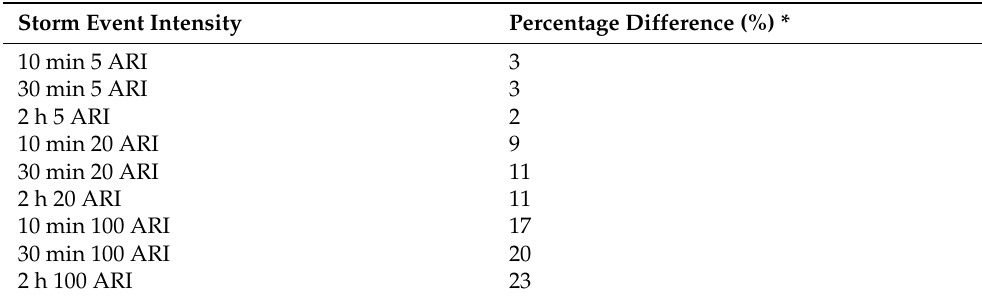
Table 1. Percentage differences in rainfall intensities between the University of Melbourne and Mt. Evelyn.